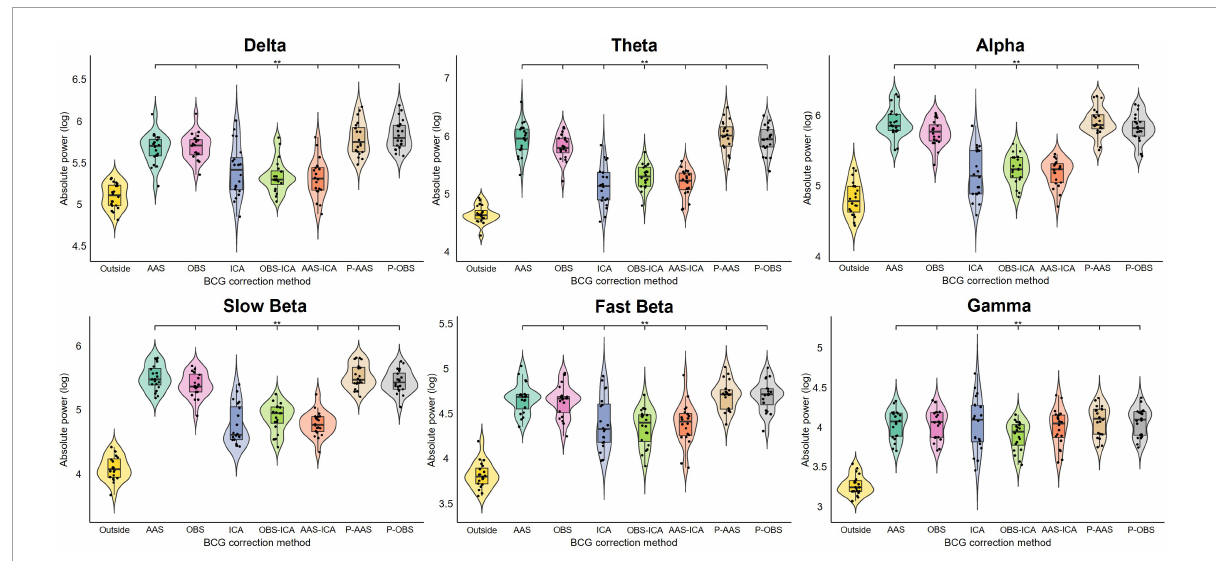
FIGURE3 Results of the repeated measures ANOVAs comparing the average absolute power of all electrodes from all subjects between the Outside rs-EEG and the rs-EEG-fMRI data corrected using each of the seven BCG correction methods. Each frequency band was analyzed separately. The asterisks indicate significant statistical differences ( p adj < 0.05) between the corrected rs-EEG-fMRI and the Outside rs-EEG data. A generalized increase in absolute power across all frequency bands was observed for the data recorded simultaneously with fMRI, which remained significant after applying all BCG correction methods. Note that PROJIC-AAS and PROJIC-OBS were abbreviated as P-AAS and P-OBS, respectively.